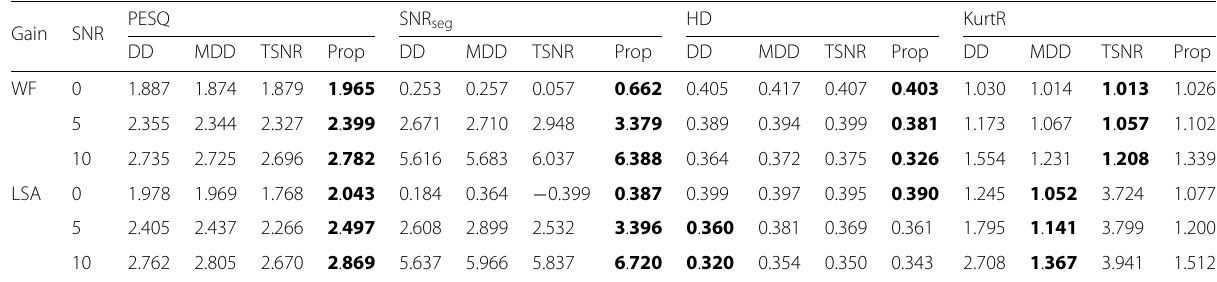
Table 4 Mean objective results for pink noise Gain SNR